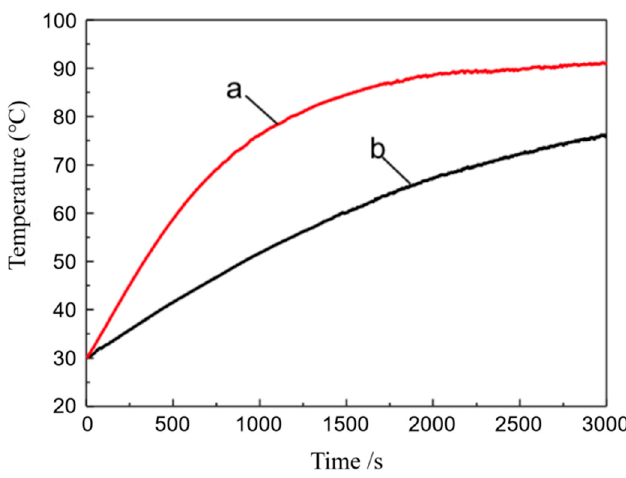
Figure 11. The time–temperature curve of water (a) and Cu 2 O nanochains-water nanofluids (b) under the irradiation of self-made analog light source.